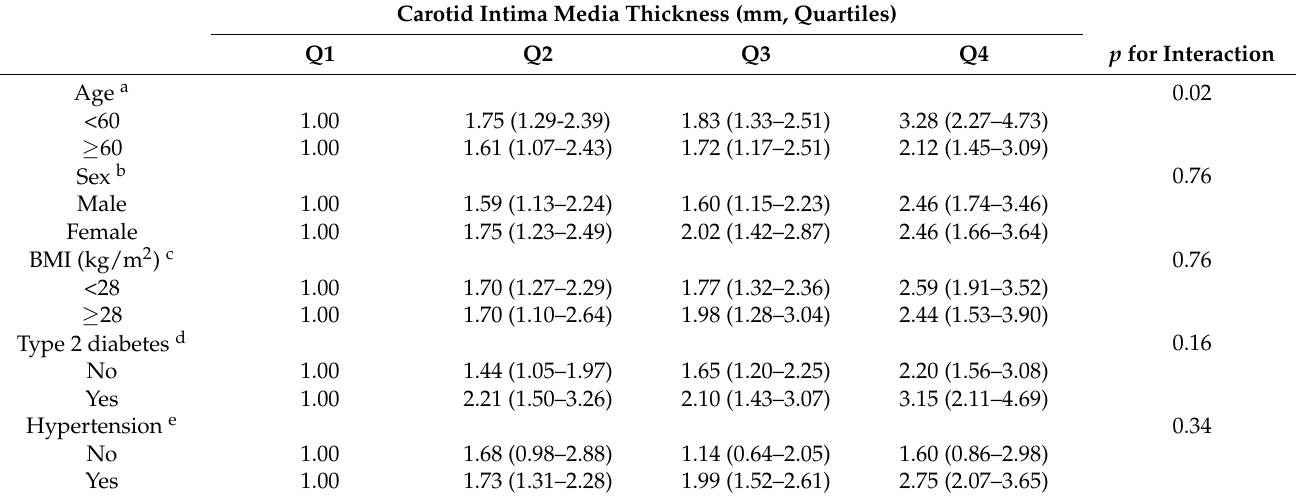
Table 3. Odds ratio and 95% confidence intervals of common carotid intima media thickness with ischemic stroke stratified by baseline risk factors.